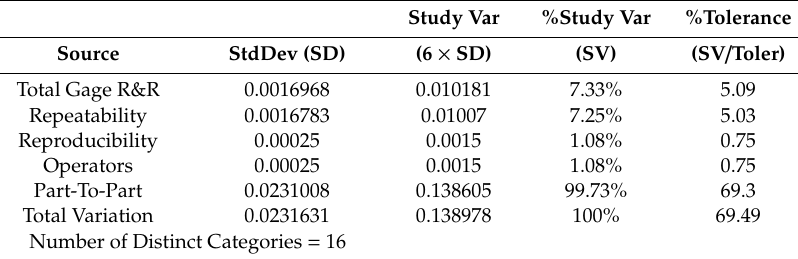
Table 4. Gage evaluation for height